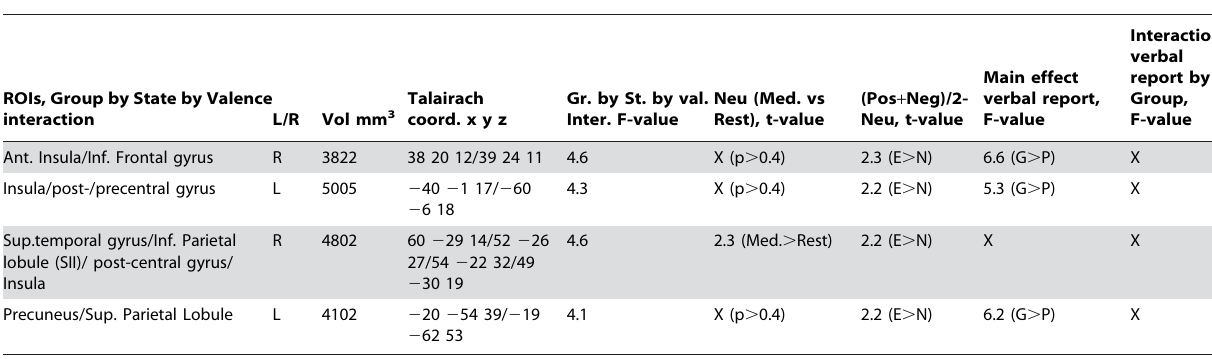
rest (r = 0.54, p , 0.05). In this cluster, there was a State-by-Group interaction, as well as a State effect, (stronger for experts than novices, ANOVA, F(1,28)= 11.3, p , 0.005 ) that was preserved even when the variation in the pupil signal was covariated out